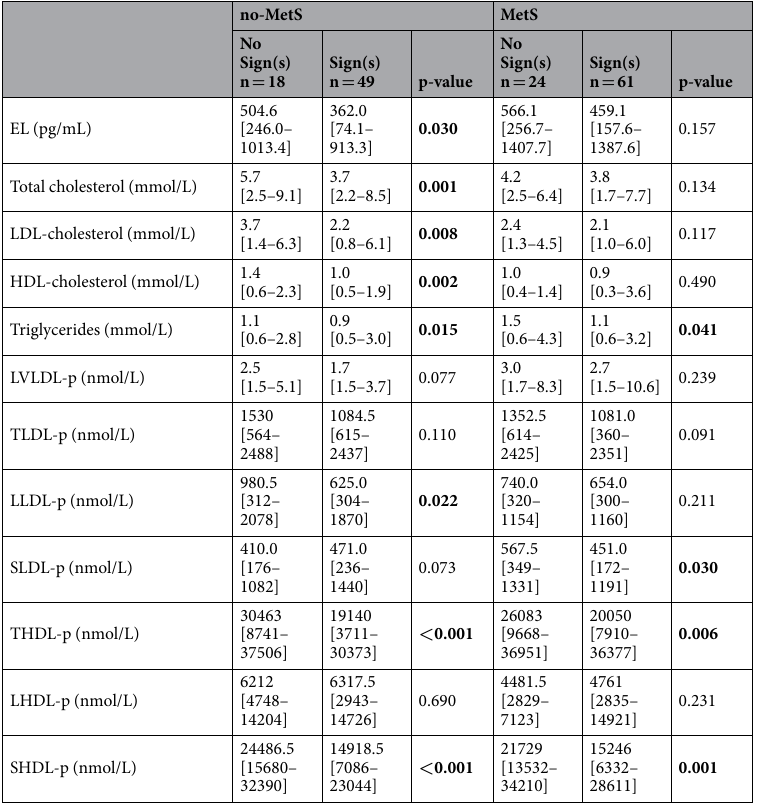
Table 4. EL and lipid/lipoprotein plasma levels in patients without or with sign(s) implying volume overload. Results are presented as median, minimum and maximum. Significant differences between patients with no sign(s) and those with one or combination of two or three sign(s) implying volume overload were calculated with Mann-Whitney U-test and are depicted in bold. HDL-high density lipoprotein; LDL-low-density lipoprotein; EL-endothelial lipase; LVLDL-p –large very low-density lipoprotein particles; TLDL-p –total LDL particles; LLDL-p –large LDL particles; SLDL-p –small LDL-p; THDL-p –total HDL-particles; LHDL-p